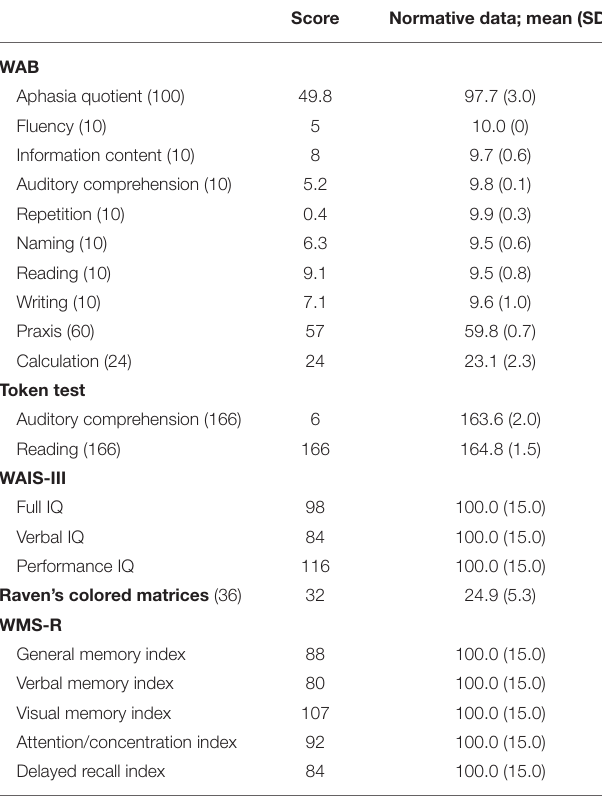
TABLE 1 | Performance on standard neuropsychological tests. Score Normative data; mean